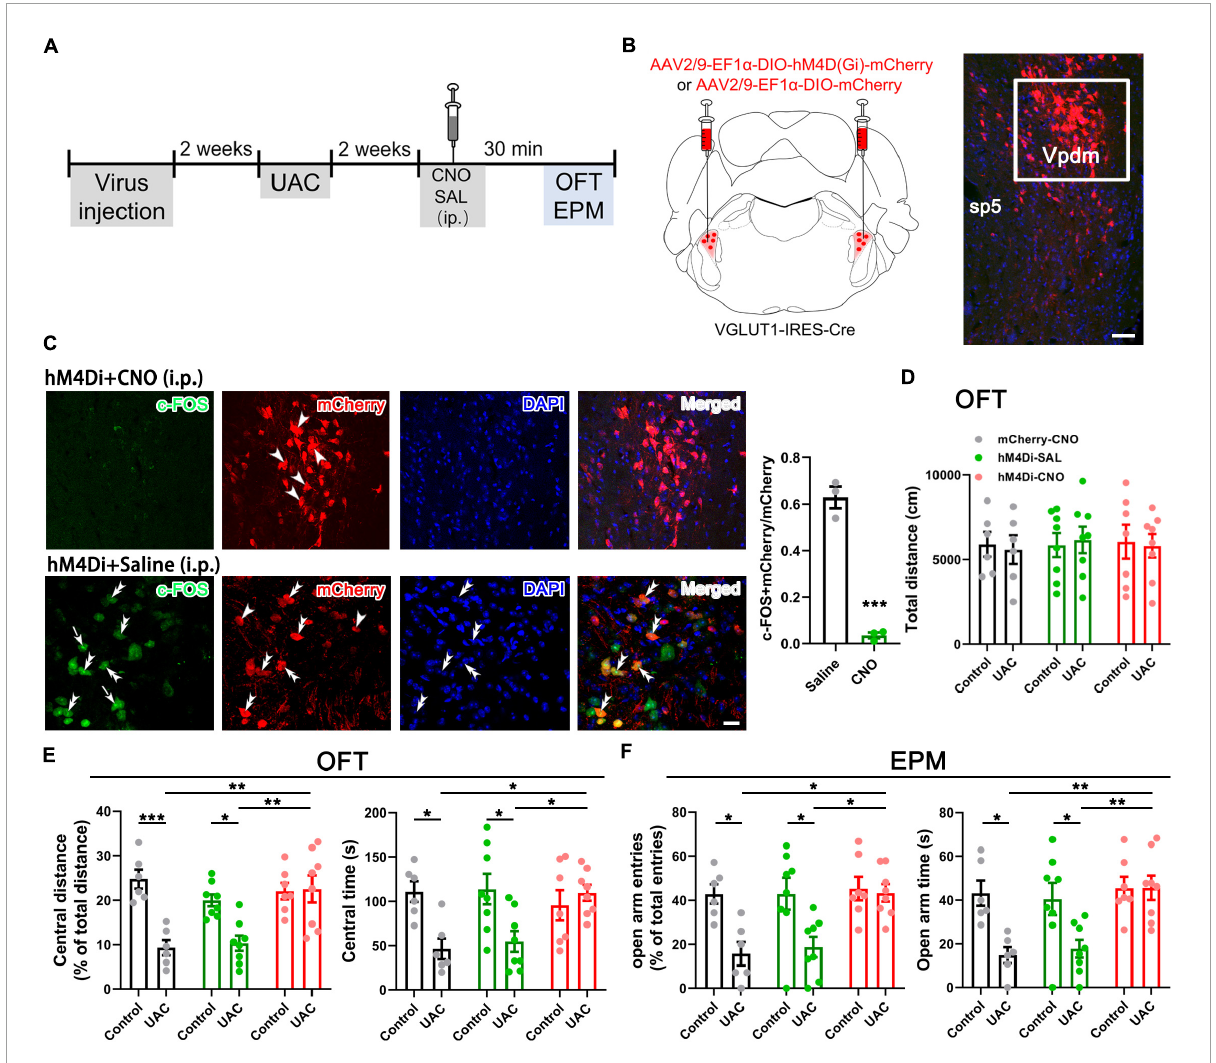
FIGURE2 Chemogenetic inhibition of VGLUT1-ir neurons in the Vpdm alleviates UAC-induced anxiety-like behaviors. (A) Timeline of chemogenetic inhibition of Vpdm VGLUT1 neurons to investigate anxiety comorbidity. (B) Schematic showing the virus injection into the Vpdm of VGLUT1-IRES-Cre mice (Left) and a representative coronal section showing the expression of the hM4D (Gi)-mCherry virus (Right). The white square is enlarged and displayed in (C) . Scale bar: 200 µ m. (C) The triple-labeling immunofluorescence histochemical staining of c-FOS (green), hM4D (Gi)-mCherry (red) and nuclear dye DAPI (blue), showing that the expression of c-FOS in the Vpdm was lower in the CNO-injected group than in the saline-injected group (Saline: n = 3; CNO: n = 3). The double arrowheads indicate c-FOS/mCherry/DAPI triple-labeled neurons. The arrows indicate c-FOS/DAPI double-labeled neurons. And the single arrowheads indicate the mCherry/DAPI double-labeled neurons. Scale bar: 20 µ m. (D) The total distance traveled in the OFT was identical under chemogenetic manipulation. (E) The inhibition of Vpdm VGLUT1 neurons increased the percentage of central distance and the time spent in the central area in the OFT. (F) The deactivation of Vpdm VGLUT1 neurons increased the percentage of open arm entries and the time spent in the open arms in the EPM. Data are expressed as the mean ± SEM. Tukey’s post hoc was performed between the groups: mCherry-CNO-treated control mice ( n = 6) versus mCherry-CNO-treated UAC mice ( n = 6), hM4Di-SAL-treated control mice ( n = 8) versus hM4Di-SAL-treated UAC mice ( n = 8), hM4Di-CNO-treated control mice ( n = 7)